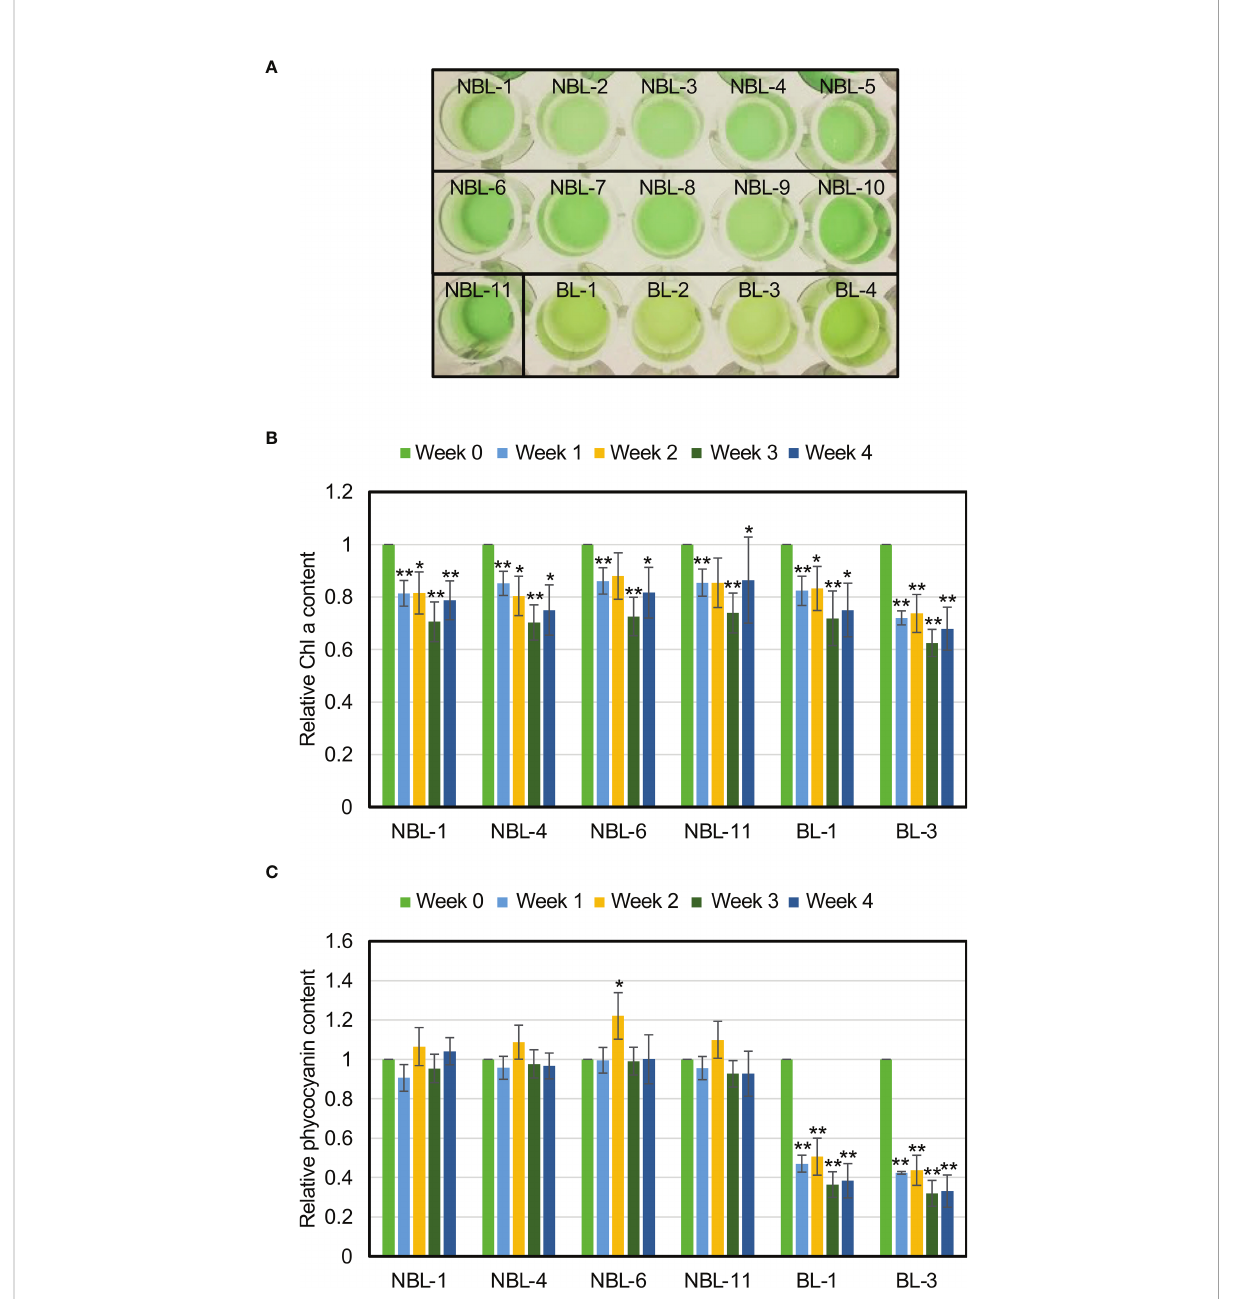
FIGURE 6 Alleviation ofphycocyanindegradation under N-depletionin the nonbleachingstrains. (A) Nonbleaching and bleaching strain cultures, afterone week of N-depletion. (B) Chl a levels for the nonbleaching and bleachingstrains. Chl a levels instrains NBL-1, NBL-4, NBL-6, NBL-11,BL-1, and BL-3,asa proportionof the value at the startofN-depletion( t -tests comparing the pre- andpost-N-depletion results for eachstrain;**p < 0.01; *p< 0.05). (C) Phycocyanin levels ofrepresentative nonbleachingand control strains. Phycocyanin levels in strains NBL-1, NBL-4, NBL-6,NBL-11, BL-1, and BL-3, as a proportion of the value at the startofN-depletion ( t -tests comparingthe pre- and post-N-depletion results for each strain; **p < 0.01; *p<